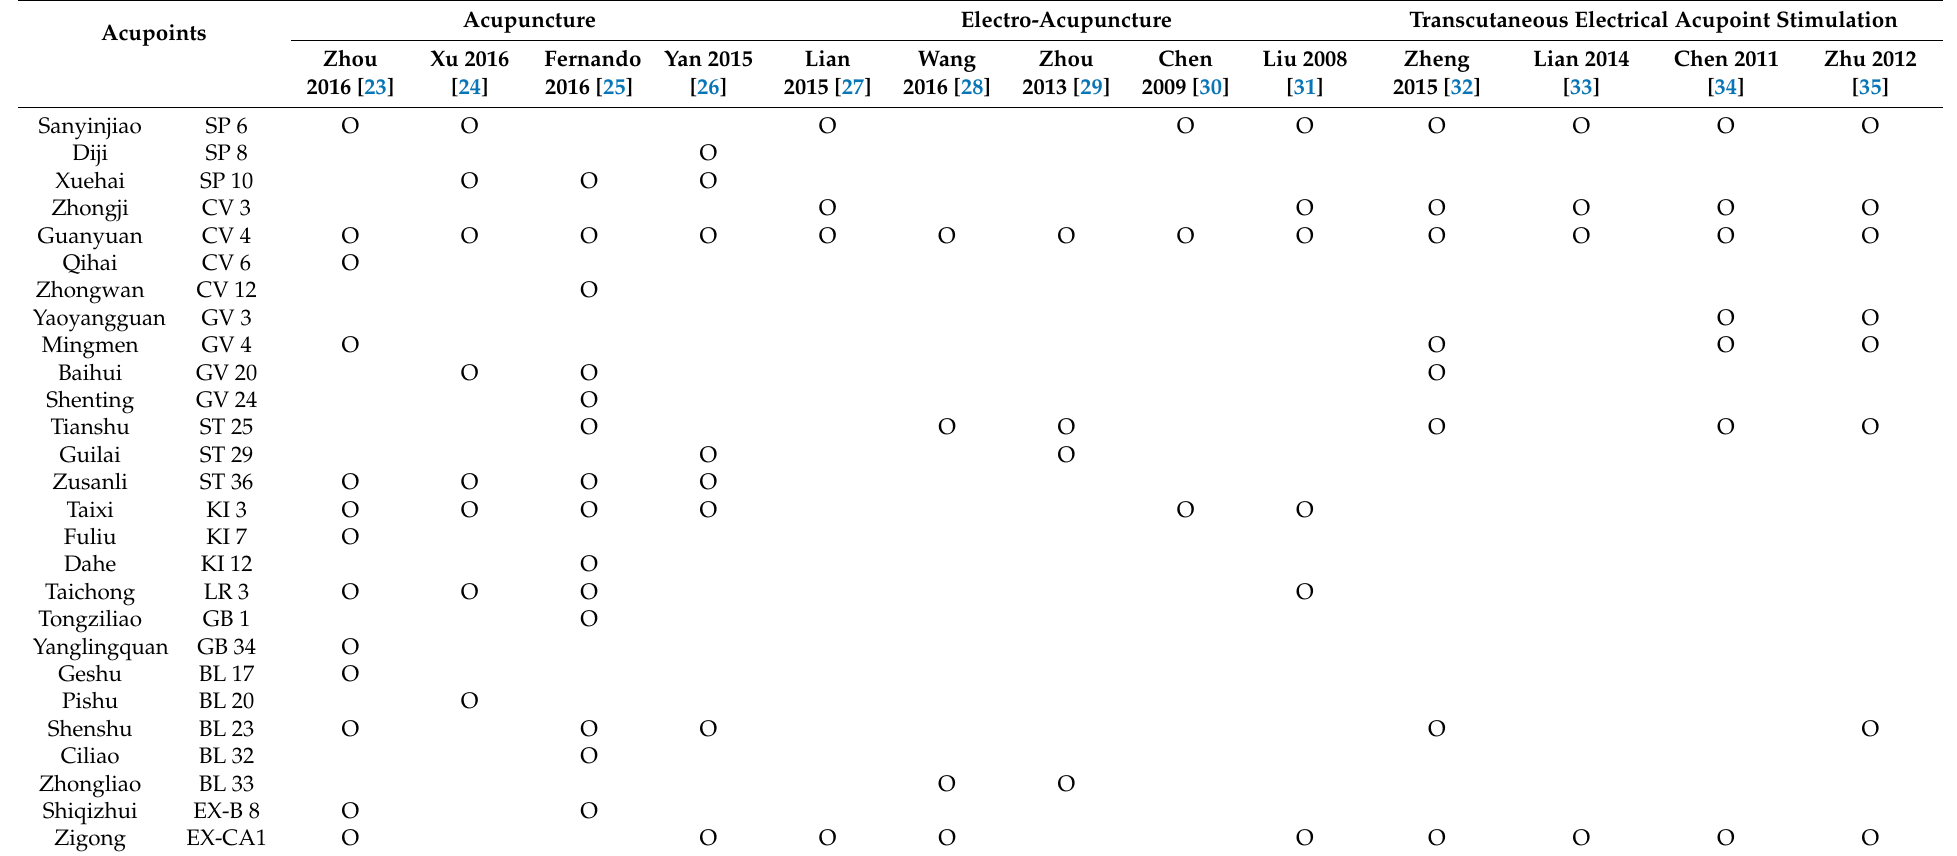
Table 2. Commonly used acupoints for acupuncture treatment in patients with poor ovarian